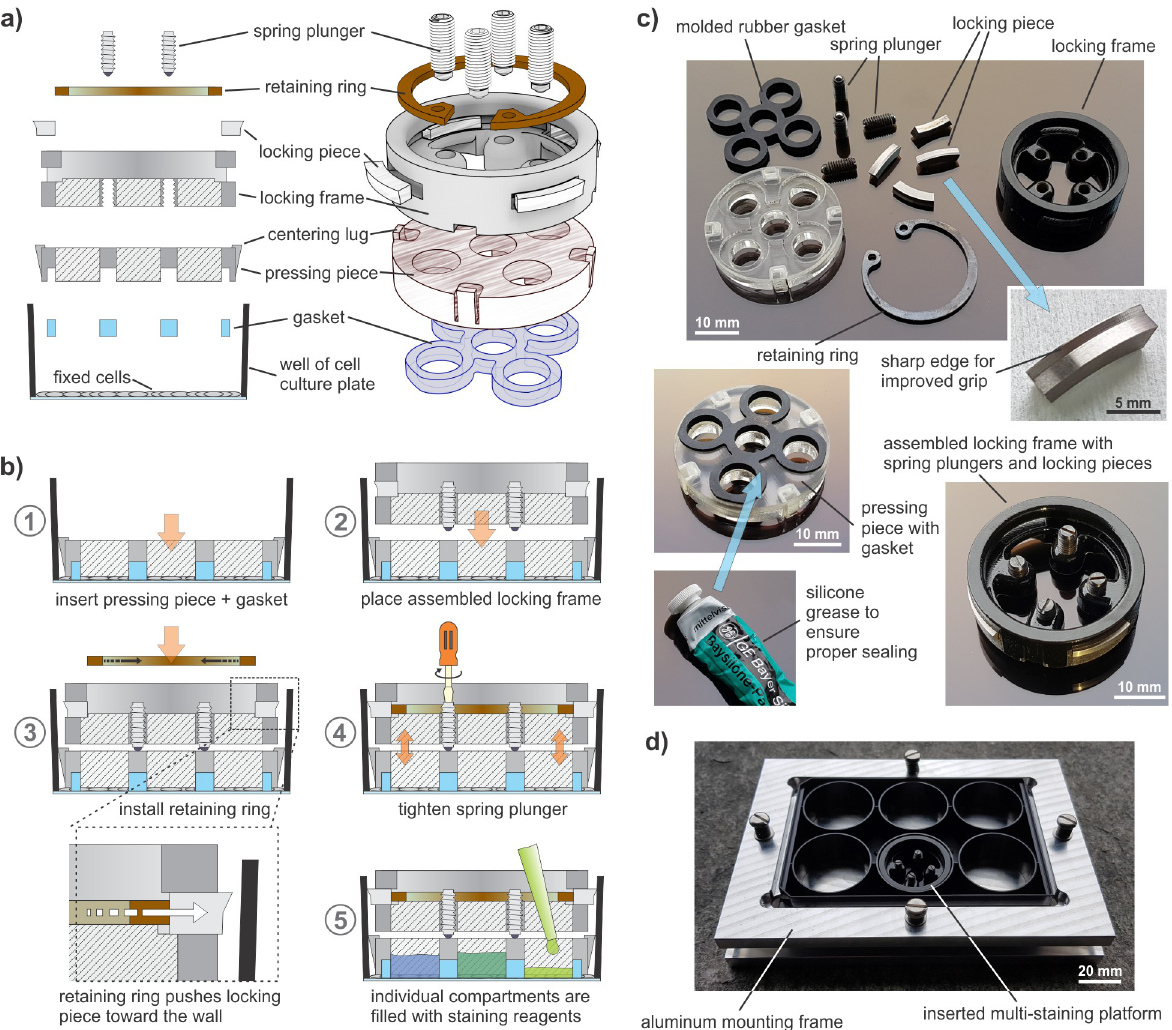
Fig 4. Assembly of a multi-staining platform insert. a) Overview schematics depicting the different pieces of the staining platform and assembly order. b) Assembly steps: (1) The pressing piece with the gasket is inserted into the well and placed directly on top of the fixed cells; (2) the locking frame is placed on top, and the centering lugs ensure proper alignment. The four locking pieces were previously inserted into the locking frame with the sharp edge facing upwards and the spring plungers inserted into the holes of the locking frame; (3) using circlip pliers, the retaining ring is compressed to fit into the groove of the locking frame, pressing the locking pieces out towards the wall of the well; (4) the spring plungers are tightened to apply vertical force; (5) the individual compartments are filled with staining reagents. c) Photographs of the different pieces and materials used for the assembly of a multi-staining platform insert. d) Photograph of the aluminum mounting frame, containing a glass-bottom 6-well plate with an inserted multi-staining